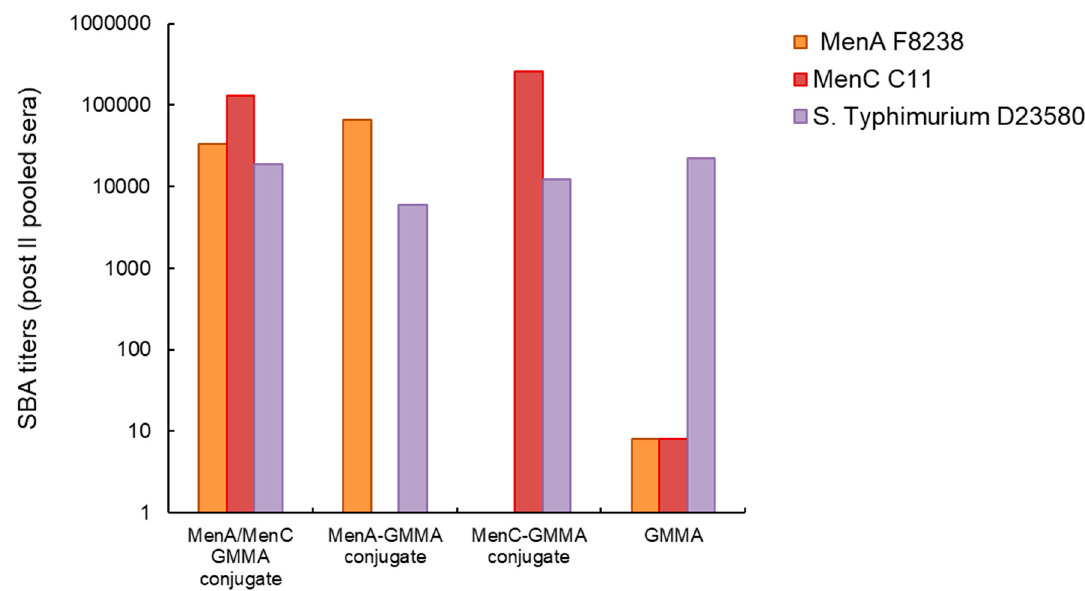
Figure 6. MenA and MenC oligosaccharides presented on the same S . Typhimurium GMMA particles compared to corresponding MenA or MenC monovalent GMMA conjugates and GMMA alone. Eight CD1 mice per group were i.m. immunized at days 0 and 28, with 1 µg MenA and MenC oligosaccharides per dose, in the presence of Alhydrogel. SBA titers of pooled sera collected 2 weeks after the second injection against MenA, MenC and S . Typhimurium strains are reported.